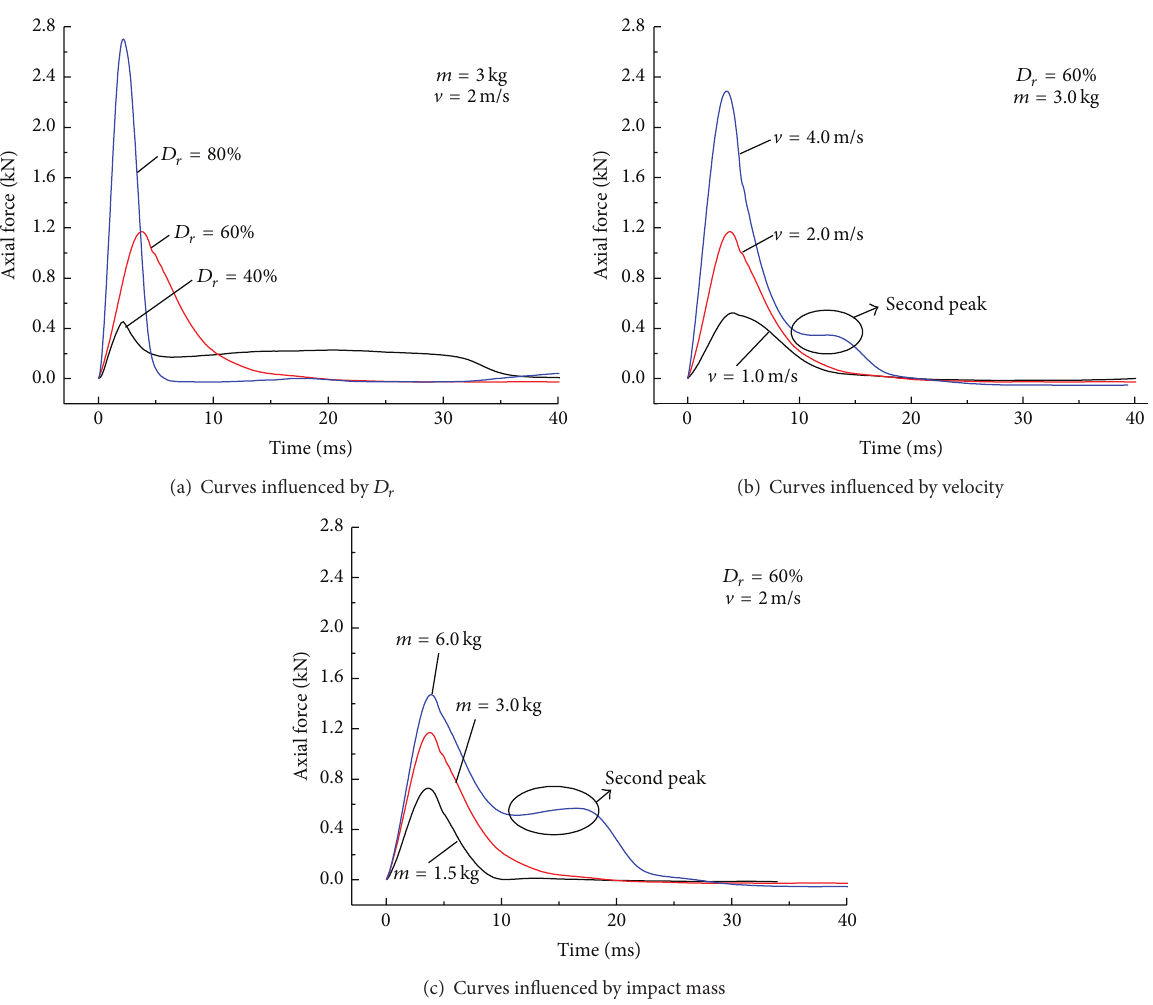
Figure 13: Time-history curves of axial force under different testing